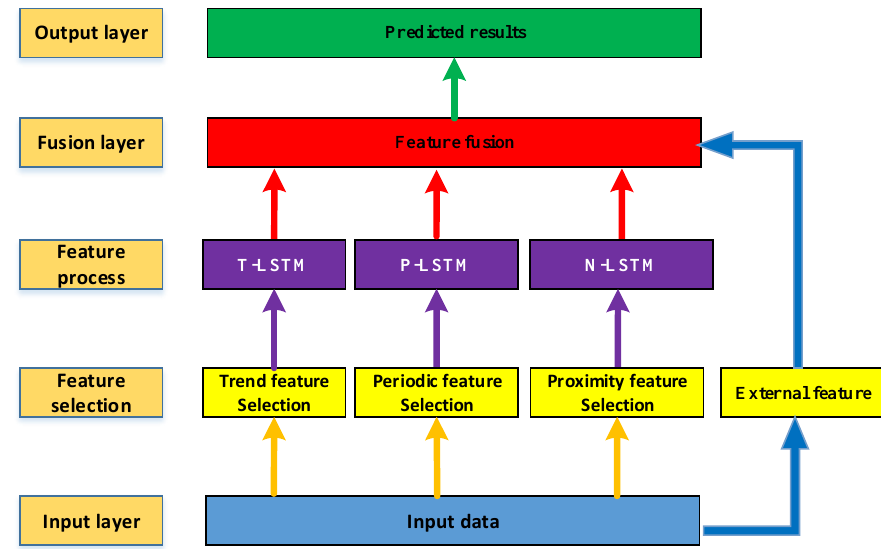
Figure 3. The overall architecture of the prediction based on the fusion algorithm of time feature extraction.